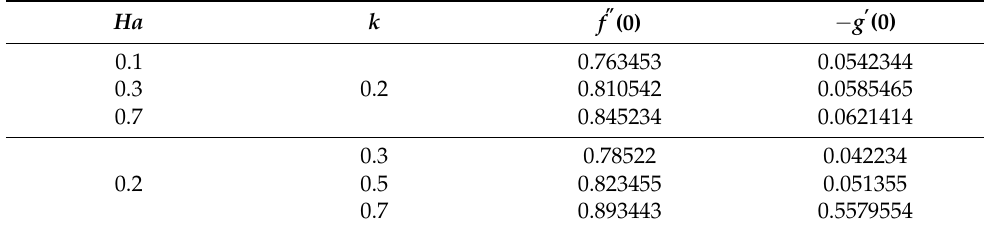
Table 3. Numerical values of f (cid:48)(cid:48) ( 0 ) and − g (cid:48) ( 0 ) for number Ha and k . Ha k f ” (0)